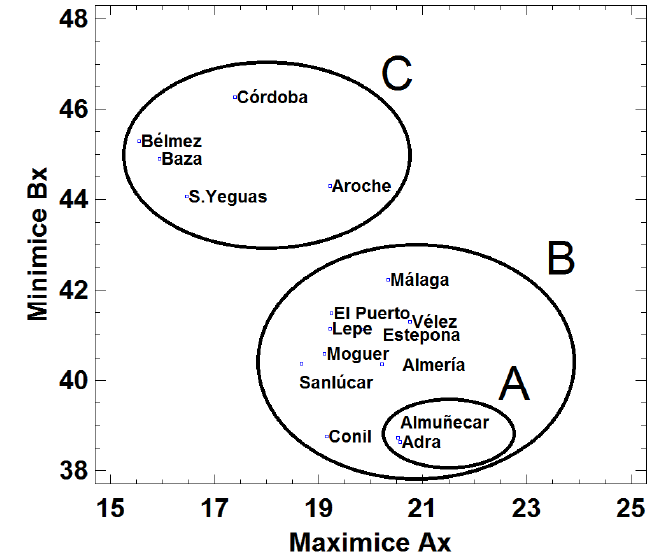
Figure A4. Locations considering Ax and Bx axes. Group named A represents the best places for the tourism rural inn, near Costa Tropical (Granada province). Sites on B are also in the coastline of the region. Sites on C are the worst locations considering the multiobjective problem, they are situated inside the